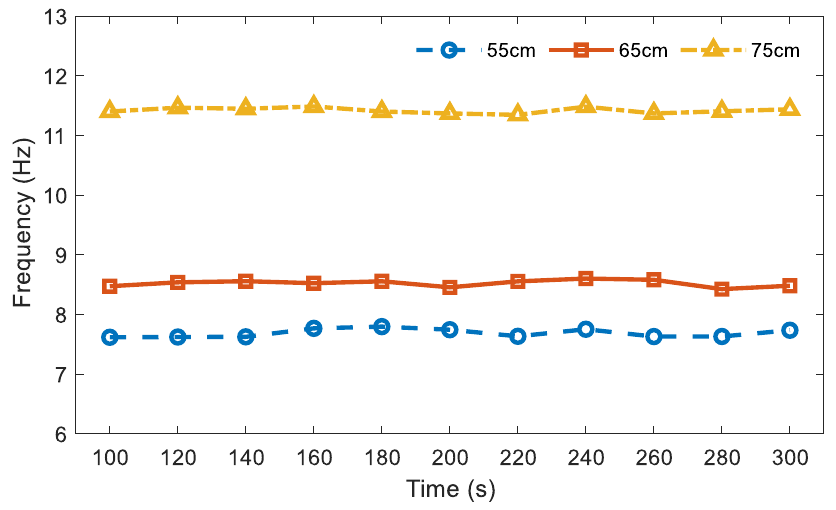
Figure 8. Frequency of the OWT with different embedment depths.